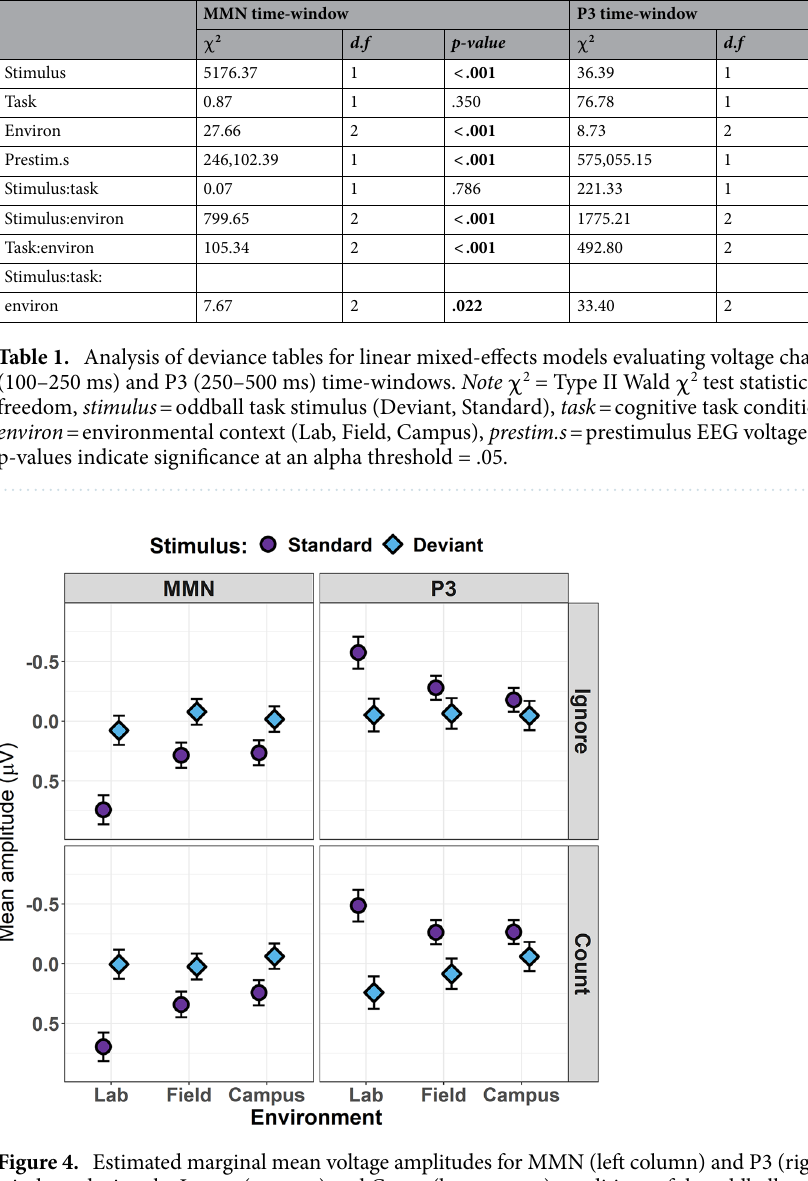
Figure 4. Estimated marginal mean voltage amplitudes for MMN (left column) and P3 (right column) time- windows during the Ignore (top row) and Count (bottom row) conditions of the oddball task. Responses to standard tone stimuli are depicted by purple circles; responses to deviant tone stimuli are depicted by blue diamonds. Estimates for each environmental condition (Lab, Field, Campus) are displayed along the x-axis of each subplot. Error bars indicate 84% confidence